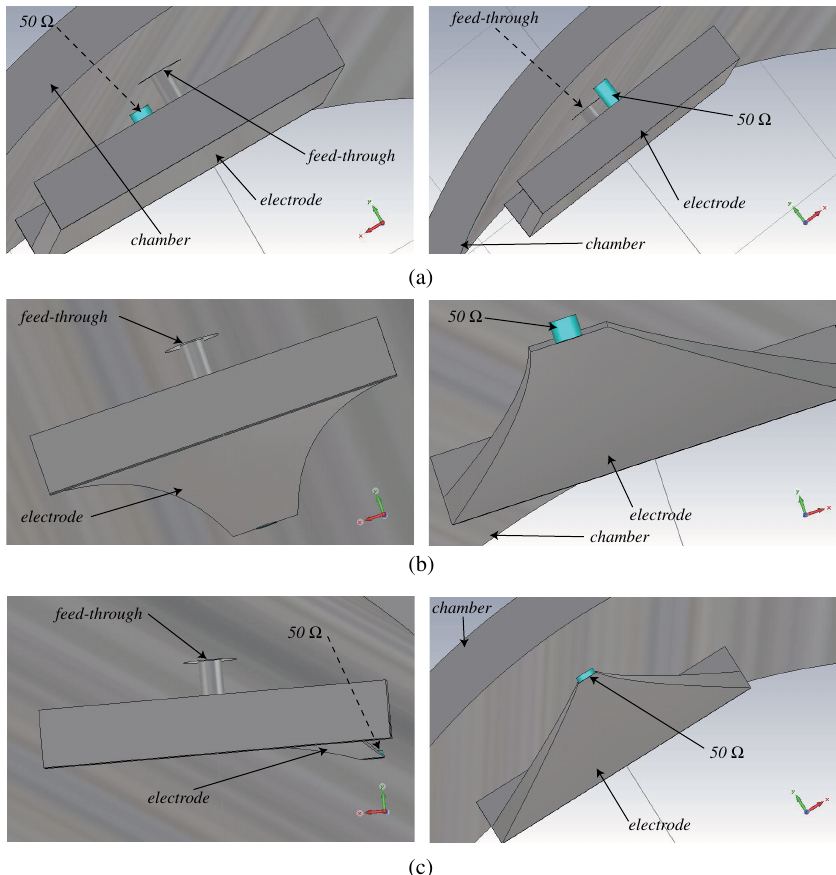
FIG. 9. A schematic picture of the electrode, where one end (upstream side) of the electrode is terminated with a 50 Ω resistor (lumped elements) behind the feedthrough. The resistor is hidden in all these figures. (a) The rectangular shape, where the left and the right parts show the upstream and the downstream sides, respectively. (b) The exponential shape, where the left and the right parts show the upstream (wider) and the downstream (narrower) ends, respectively. (c) The polynomial shape, where the left and the right parts show the upstream (wider) and the downstream (narrower) ends,